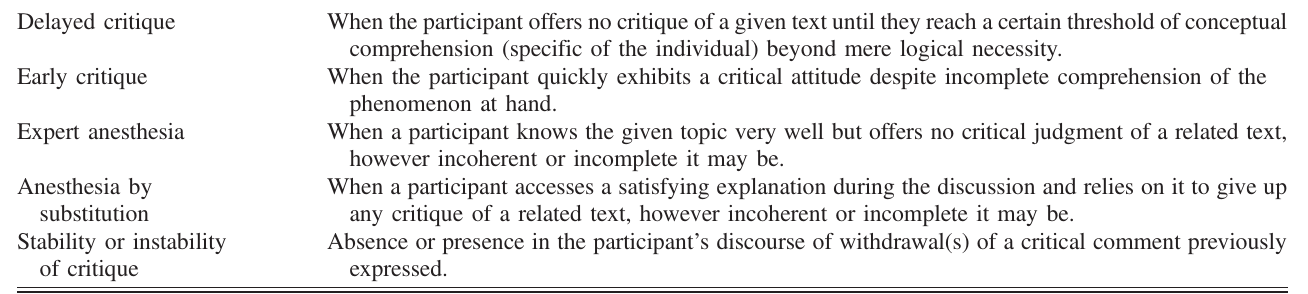
TABLE II. Categories used to describe participants ’ intellectual dynamics